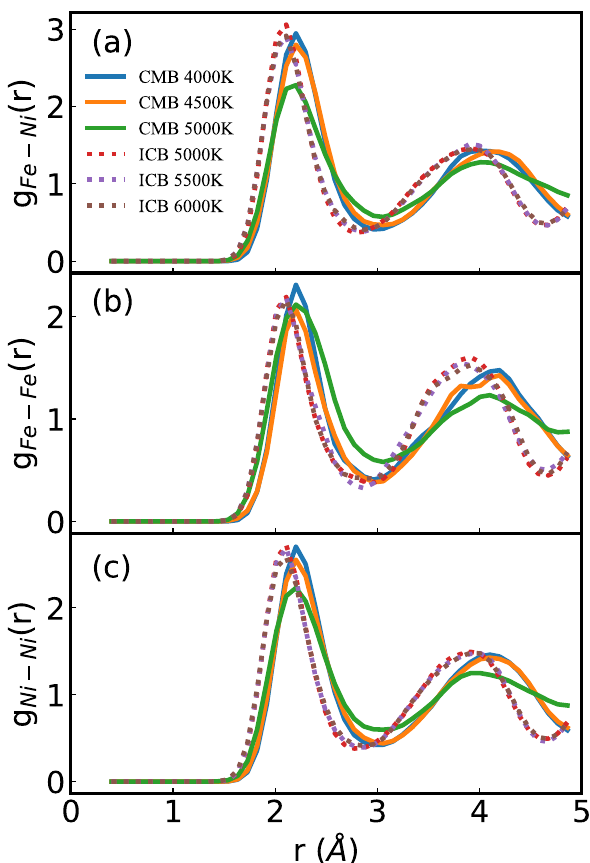
Figure 1. Pair correlation functions of ( a ) Fe–Ni ( g Fe-Ni (r) ), ( b ) Fe–Fe ( g Fe-Fe (r) ) and ( c ) Ni–Ni (g Ni-Ni (r)) in FeNi fluid under Earth’s core condition. The label ‘ICB’ and ‘CMB’ represent pressure at 330 GPa and 136 GPa,